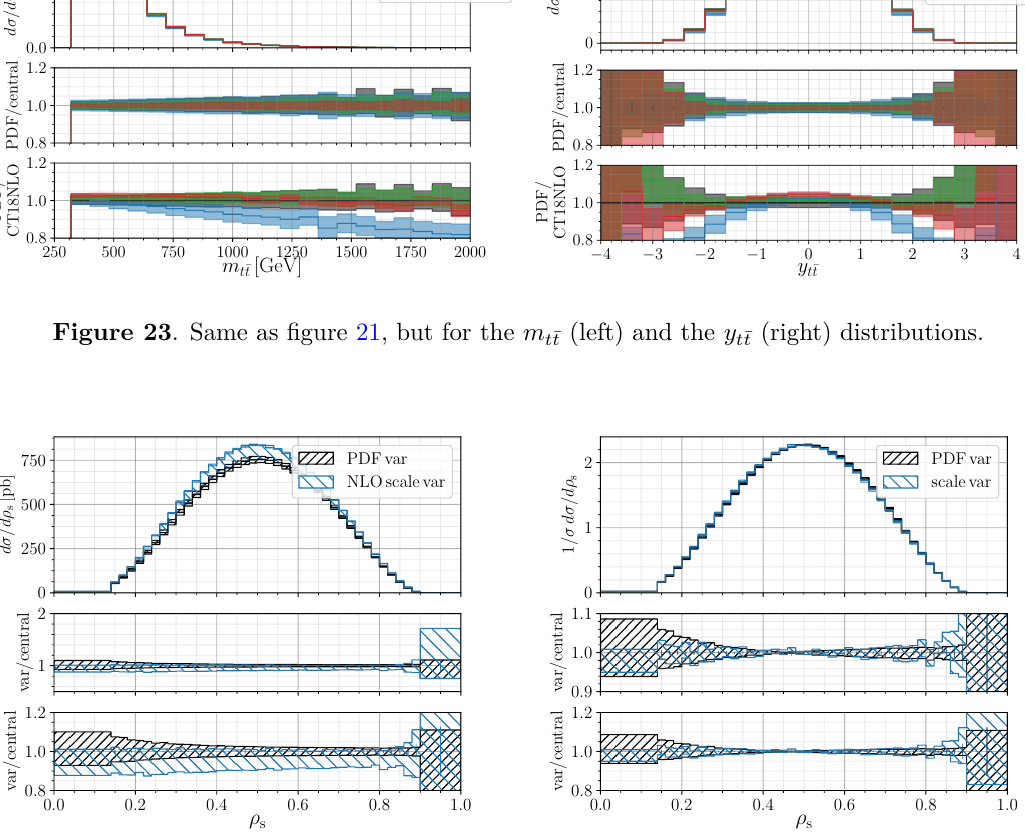
Figure 24 . Predictions for the absolute (left) and normalized (right) ρ s distribution in a LO compu- tation with scale µ 0 = H B / 4 , including PDF uncertainties computed with the CT18 NLO PDF sets T and seven-point scale variation uncertainties. The CT18 NLO uncertainty band is rescaled to 68% C.L. The α s ( M Z ) value is fixed according to the prescription associated to each PDF set and two- loop α s evolution is considered. The computation of the PDF uncertainty was done by using LO par- tonic cross sections, while the scale uncertainty was computed with the NLO partonic cross